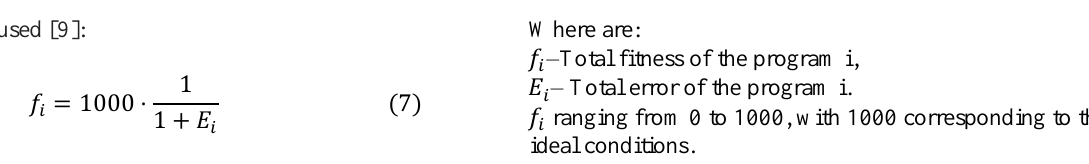
Figure 7: Empirical model for predicting subsidence above panels (cover thicknesses 50 m to 150 m and low to high SRP zones). Source